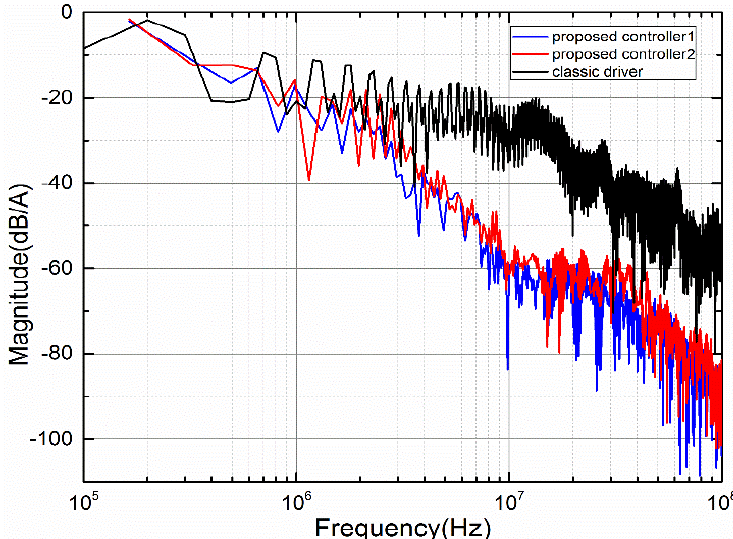
Figure 18. Spectra comparison for I d between classic gate driver (black), proposed controller 1 (blue) and proposed controller 2 (red).